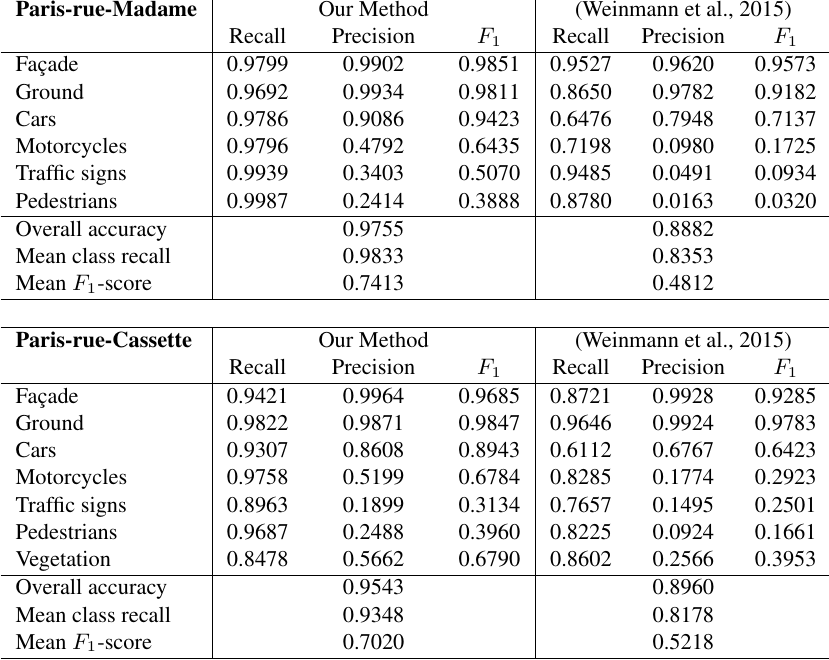
Table 2. Quantitative results for iQmulus / TerraMobilita and Paris-Rue-Madame databases.